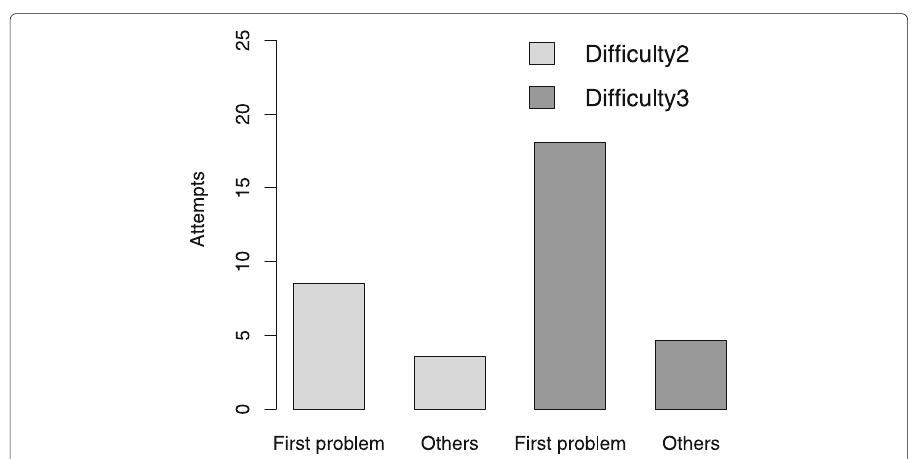
Fig. 8 Comparison between performance on the first problem and on the remaining problems for level 3-2 and difficulties 2 and